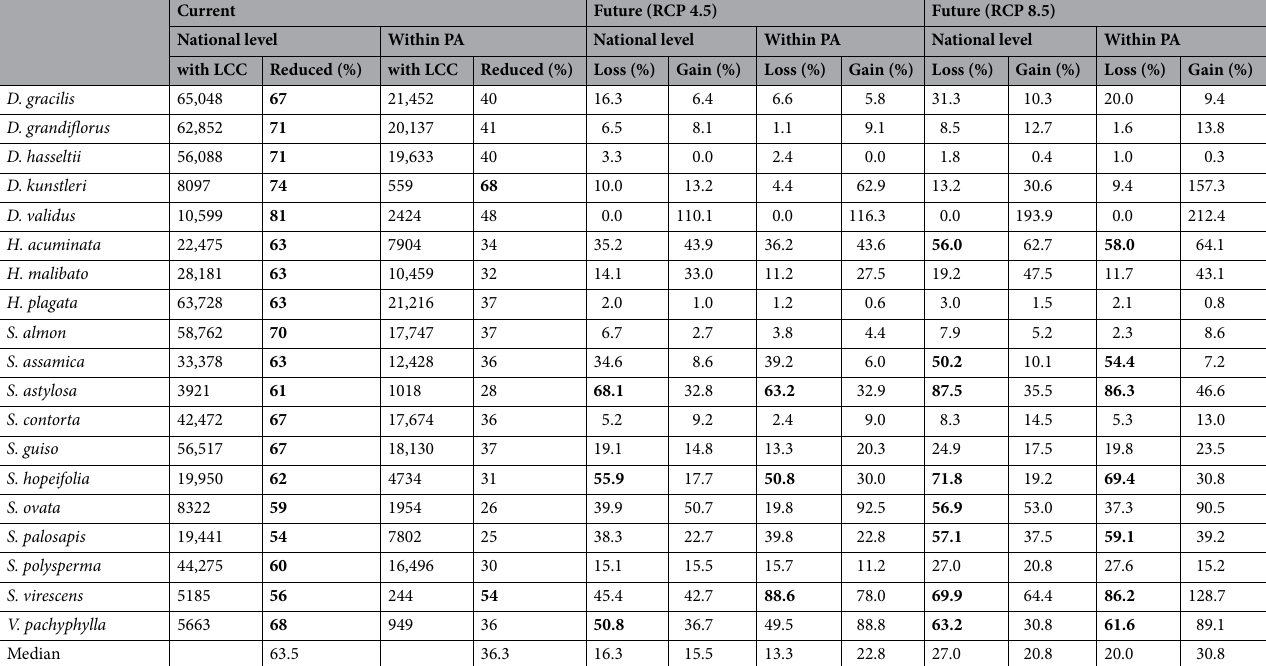
Table 2. The total potential distribution to the nearest km 2 for each species with LCC applied, at the National level and within protected areas (PA), for the current climate scenario. Reduced, indicates the percentage of the species distribution that was removed due to LCC. Future projections show as a percentage of the current distribution (with LCC), suitable area loss, refugia, or gain for both the National level and Within PA. Projections were done for RCP 4.5 and RCP 8.5 for 2070. Percentages in bold indicate a greater than 50% loss of suitable